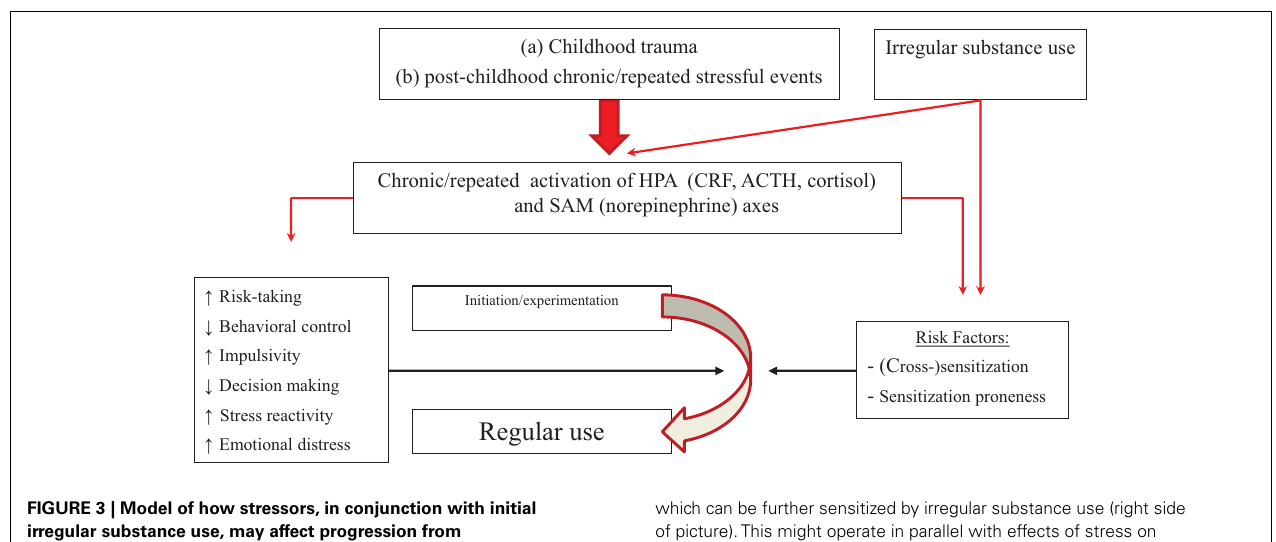
FIGURE 3 | Model of how stressors, in conjunction with initial irregular substance use, may affect progression from experimentation to regular use . Repeated stress can cross-sensitize motivational systems to the motivating effects of substances of abuse,